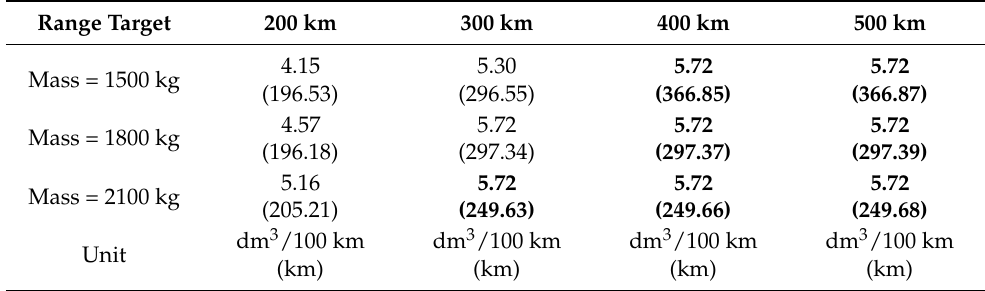
Table A12. Fuel consumption in EREV mode for constant speed drive at 110 km/h.